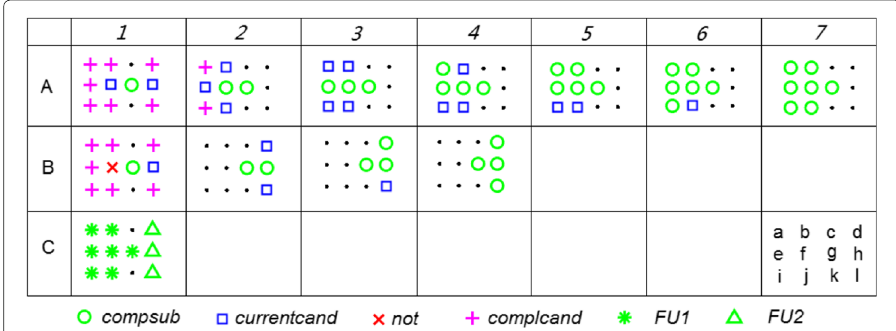
Fig. 5 Illustration of Voronoi-connected maximal clique detection using the MCB method for a coherence network with the coherence matrix shown in Table 1 and associated adjacency matrix shown in Table 2. C7 illustrates the vertex positions in the 2D space. Compare to Fig.